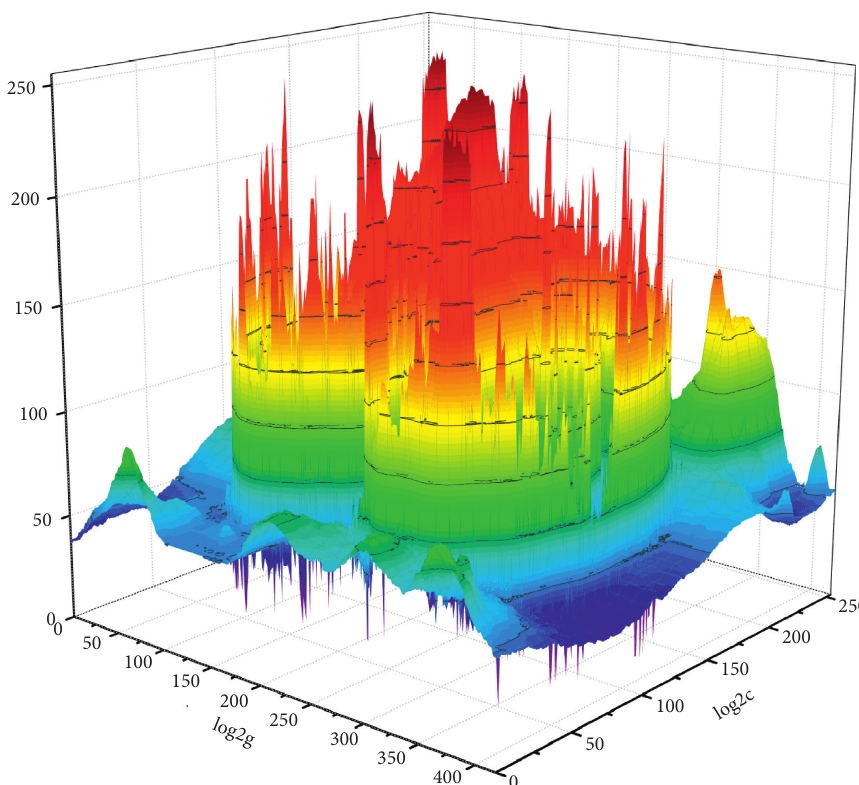
Figure 2: Grid parameter selection results for the error action recognition